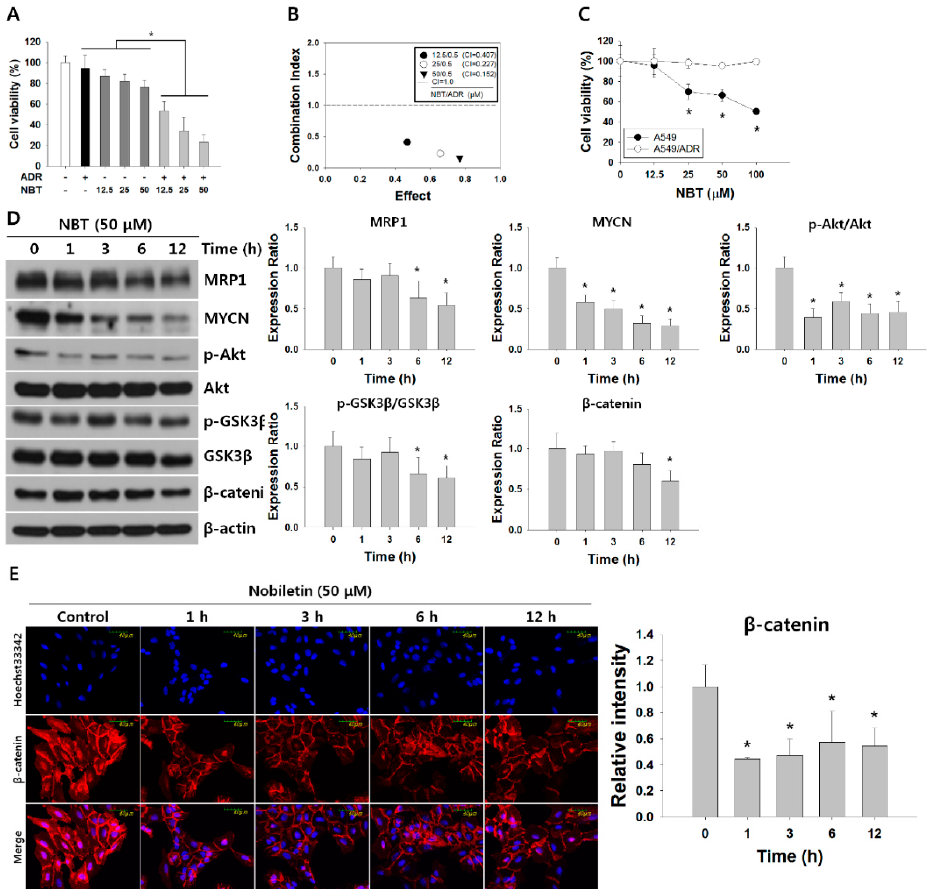
Figure 5. Nobiletin (NBT) enhances chemosensitivity of ADR by downregulating multidrug resistance-associated protein 1 (MRP1) expression through inhibiting Akt/GSK3 β / β -catenin/ neuroblastoma-derived MYC (MYCN) in A549/ADR cells. ( A ) Cytotoxicity of ADR on A549/ADR cells treated with or without NBT as measured by MTT assay. ( B ) Combination index (CI) for various concentrations of NBT with ADR in A549/ADR cells. ( C ) Cytotoxicity of NBT in A549 and A549/ADR cells as measured by MTT assay. ( D ) MRP1 and Akt/GSK3 β / β -catenin/MYCN signaling pathway expression levels in NBT-treated A549/ADR cells analyzed by Western blotting. ( E ) A549/ADR cells treated with NBT time dependently and analyzed by confocal immunofluorescence microscopy for Hoechst33342 (blue) and β -catenin (red) and their areas of overlap. Representative examples of three independent experiments are shown. Data are expressed as mean ± SD. * p <